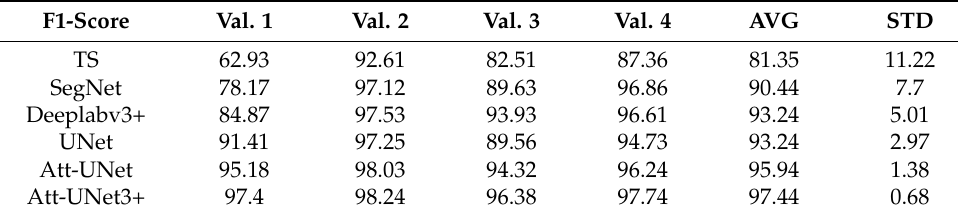
Table 5. F1-Score results of different methods in each validation sample